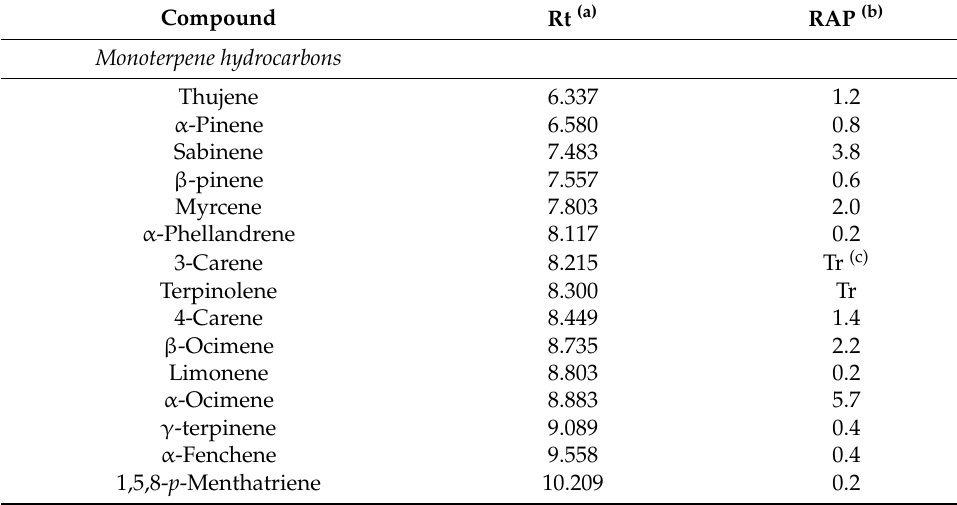
Table 1. Phytochemical profile of O. heracleoticum essential